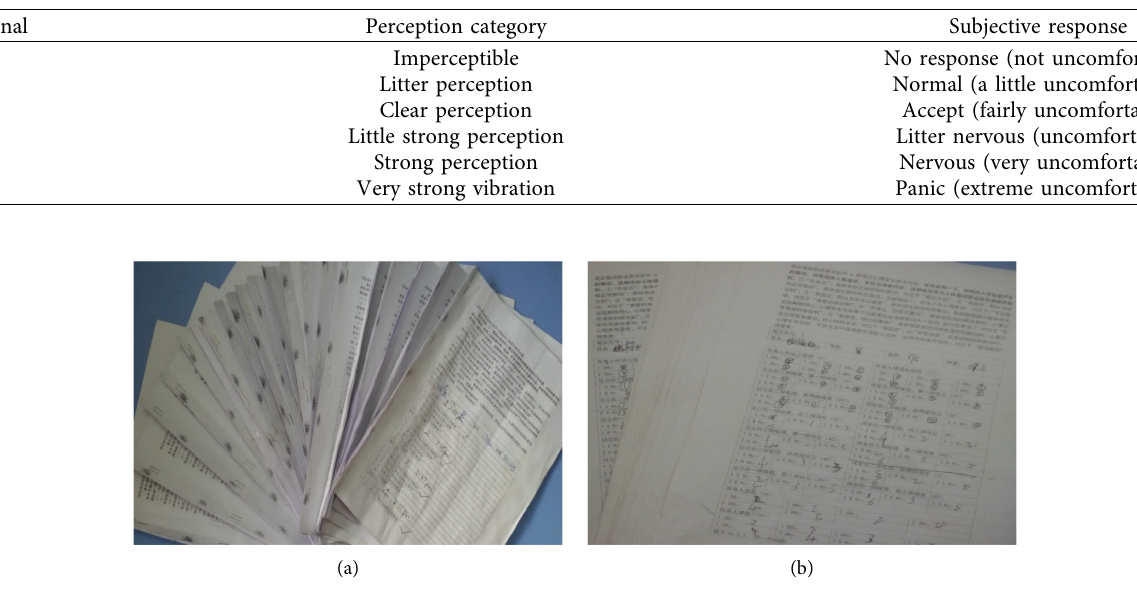
Figure 4: Participant response questionnaire. (a) The questionnaires of shaking table test; (b) the questionnaires of human induced